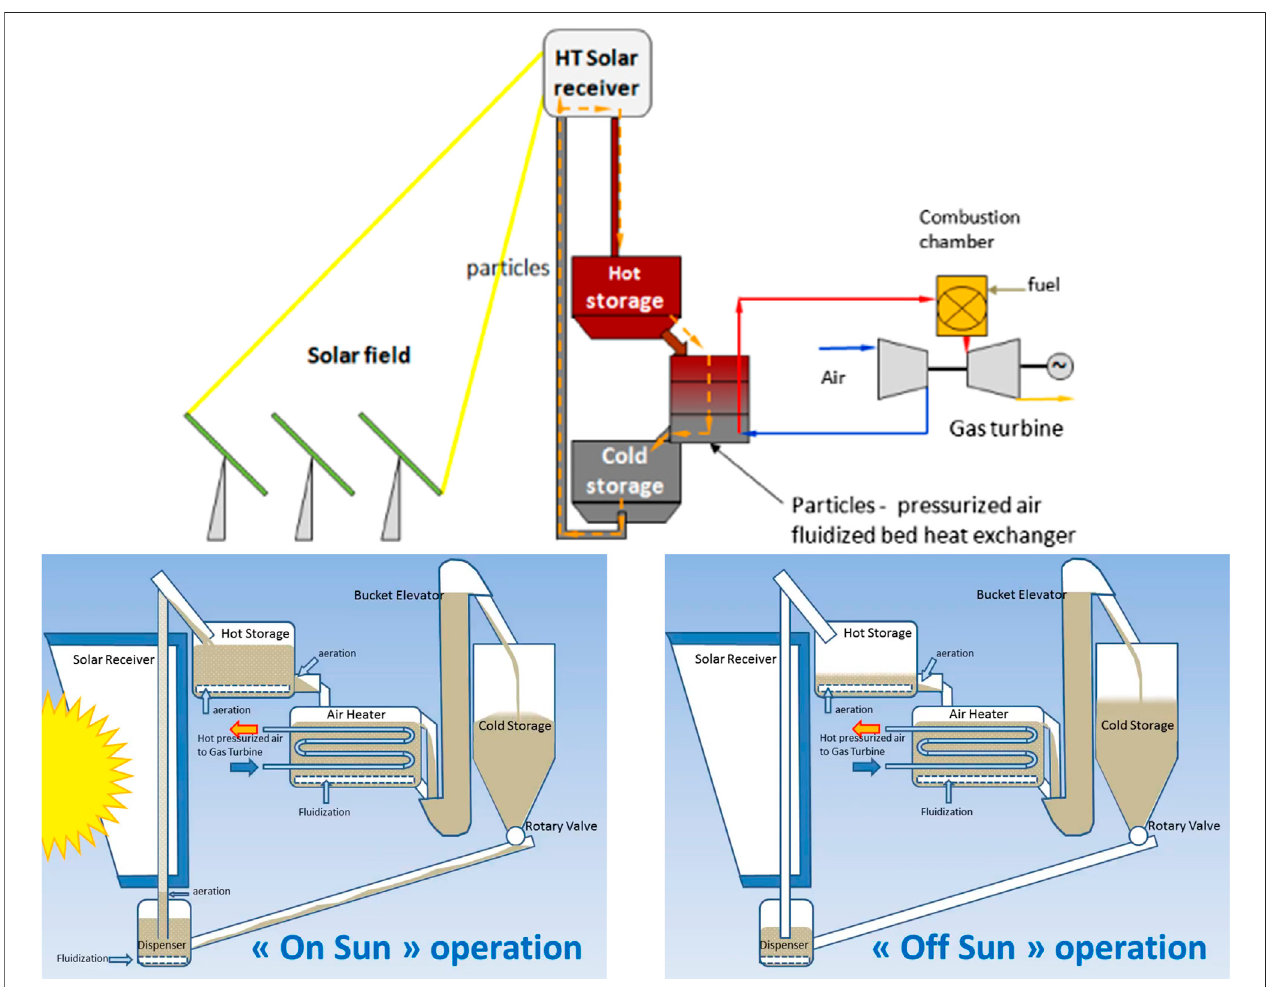
FIGURE 4 | Fluidized particle-in-tube concept: process schematic and on-sun and off-sun loop operation (adapted from Next-CSP, 2016).